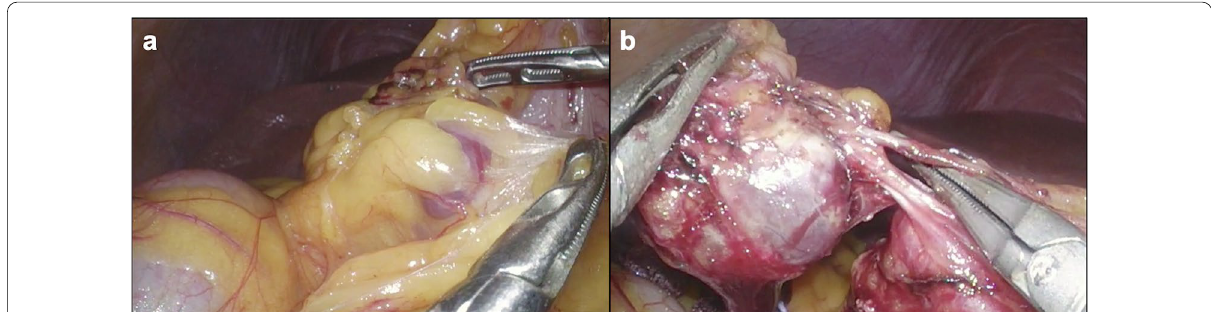
Fig. 2 Intraoperative findings. a The tumor was identified at the omentum. b The tumor was attached to a branch of the RGV